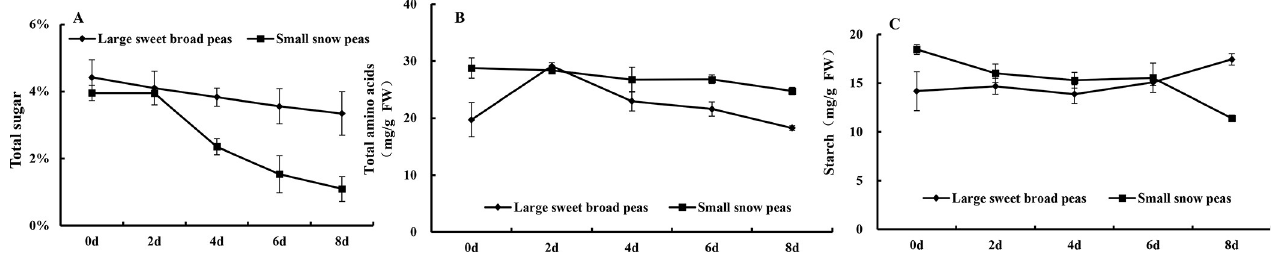
Fig 3. Changes in total sugar (A), total amino acid (B), and total starch (C) contents in two types of snow pea during storage.